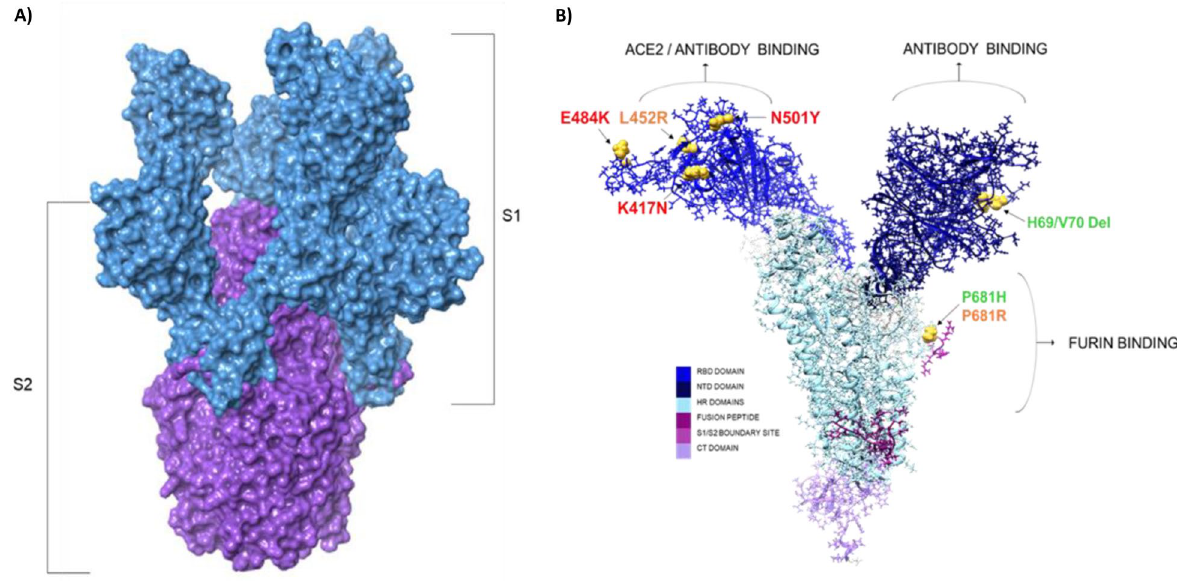
Figure 6. Schematic representation of SARS-CoV-2 spike glycoprotein: Schematic representation of SARS- CoV-2 spike glycoprotein: ( A ) Surface area representation of trimeric spike protein conferring an “open conformation” RBD domain (S1 domain depicted in blue and the S2 domain represented in purple) ( B ) Atomistic representation of characterized subdomains within the monomeric spike protein and the spatial mapping of defined protein binding regions. The identified VOCs within the RBD, NTD and S1/S2 boundary site are also demonstrated. The Alpha variant mutation and deletion are represented in green, the Beta variant in red and the Delta variant in